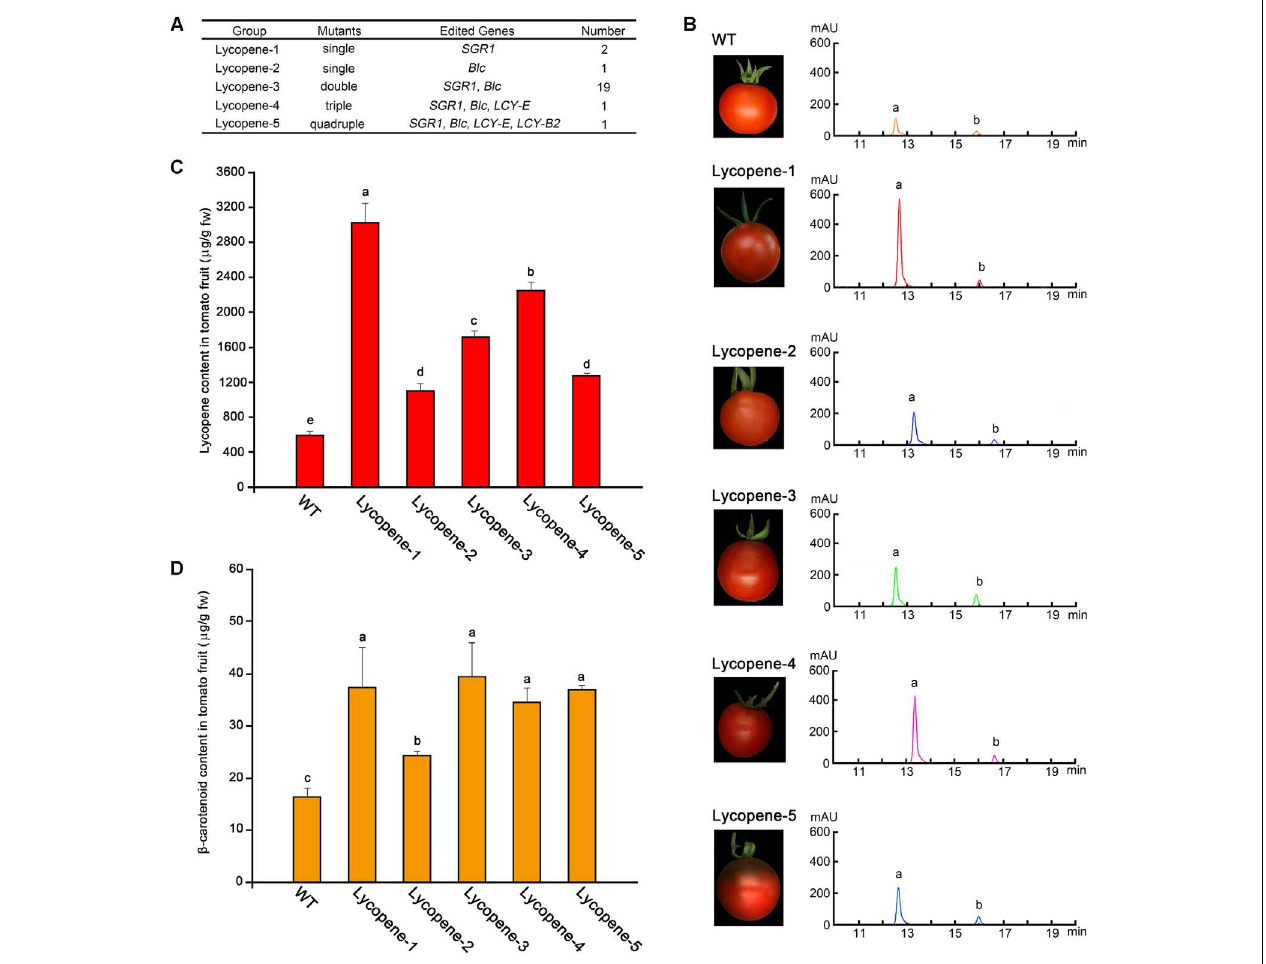
FIGURE 3 | Determination of lycopene content in tomato fruit at Br+7 from different mutant groups. (A) List of different groups of lycopene mutants according to the different combinations of mutant genes. (B) HPLC results of crude extracts from tomato fruit samples in different groups. a, b, lycopene and β -carotenoids, respectively. (C,D) Contents of lycopene and β -carotenoids of tomato fruit in the five different groups and WT, respectively. Error bars represent standard deviation. Different lowercase letters show statistically significant difference according to ANOVA followed by Duncan’s test ( p <